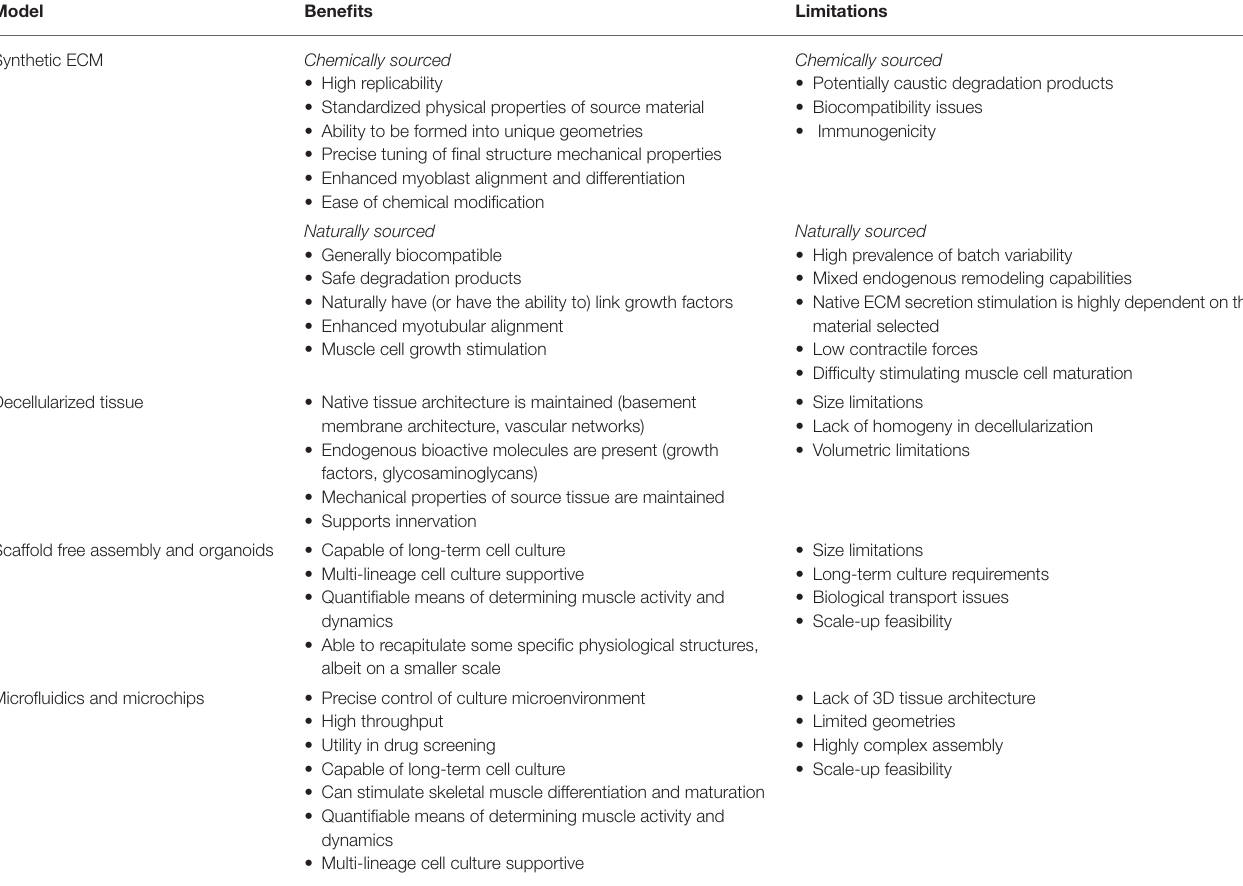
TABLE 1 | Bioengineering skeletal muscle